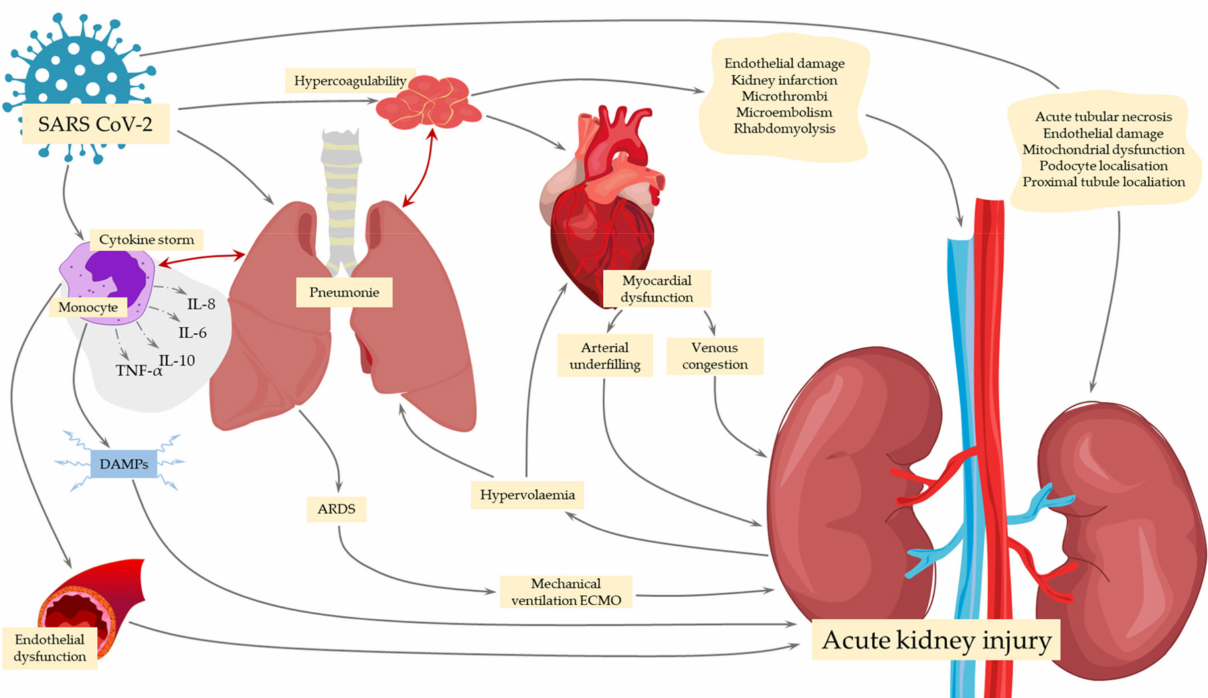
Figure 1. The consequences of SARS CoV-2 infection leading to AKI. SARS CoV-2, severe acute respiratory syndrome coronavirus 2; IL, interleukin; ARDS, acute respiratory distress syndrome; DAMPs, damage-associated molecular patterns; ECMO, extracorporeal membrane oxygenation; TNF- α , tumor necrosis